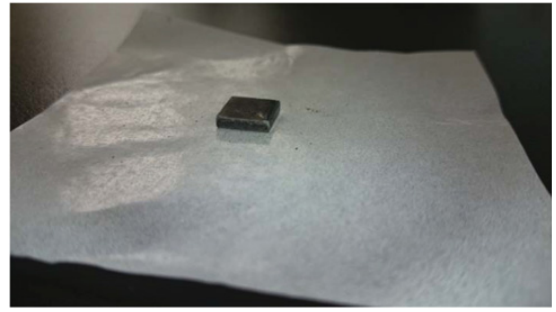
Figure 7. Packed DNP